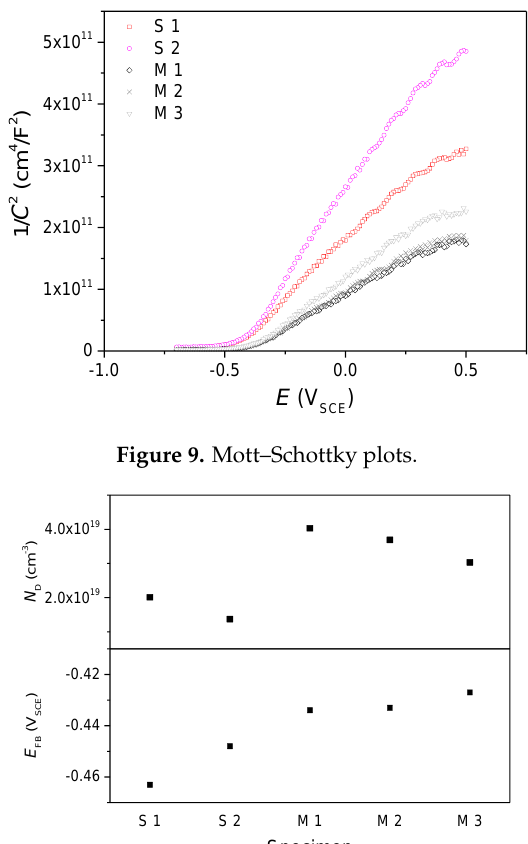
Figure 9. Mott–Schottky plots.